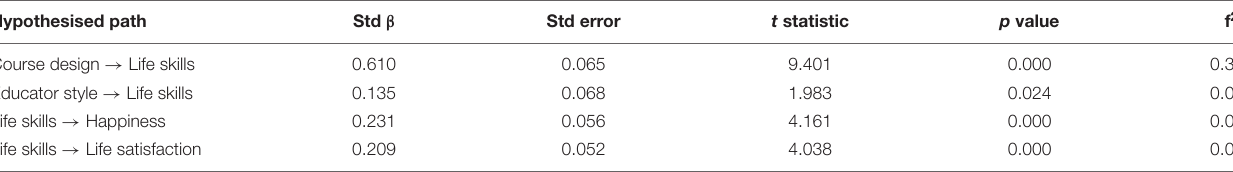
TABLE 5 | Path coefficients, t statistics, and effect size (f 2